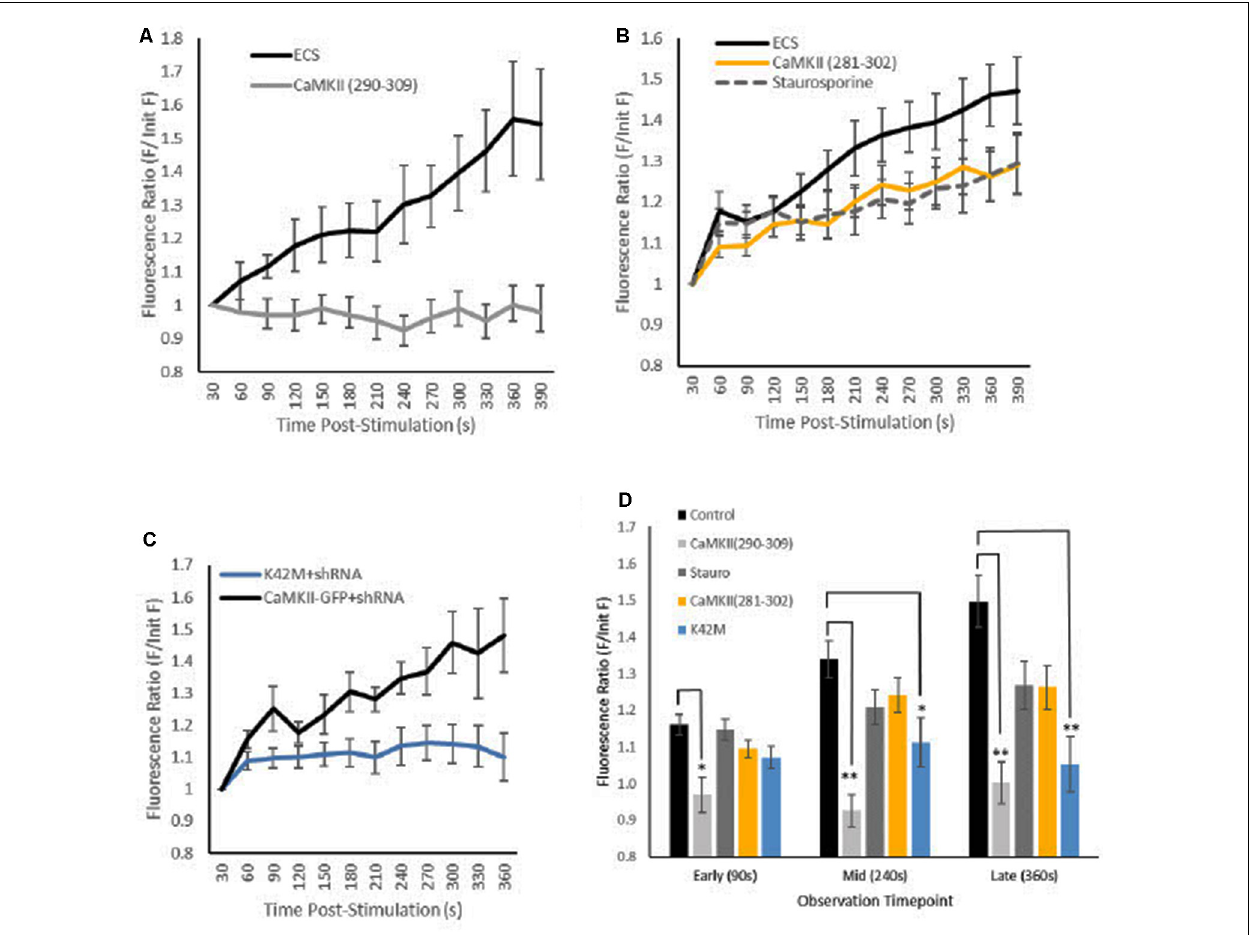
FIGURE 2 | Effects of CaMKII inhibition on GFP-CaMKII translocation. Fluorescence levels (A–C) [Mean ( ± SEM)] of GFP-CaMKII-expressing puncta relative to initial GFP-CaMKII fluorescence levels across post-stimulation time points captured at 30-s intervals. (A) GFP-CaMKII expression in control (ECS; n = 10) and in the presence of the CaMKII(290–309) peptide inhibitor ( n = 10). (B) GFP-CaMKII in control (ECS, n = 14), staurosporine ( n = 12) or in the presence of the CaMKII(281–302) peptide inhibitor ( n = 10). (C) CaMKII knockdown and re-expression of GFP-CaMKII ( n = 6) or GFP-CaMKII(K42M; n = 16). (D) Mean ( ± SEM) relative GFP-CaMKII punctal fluorescence levels at early (90 s), mid (240 s) and late (360 s) translocation time points by condition. ECS and GFP-CaMKII knockdown and re-expression conditions combined as there was no significant difference between these control conditions ( F (18,38) = 1.008, p > 0.40). ∗ p < 0.05, ∗∗ p <